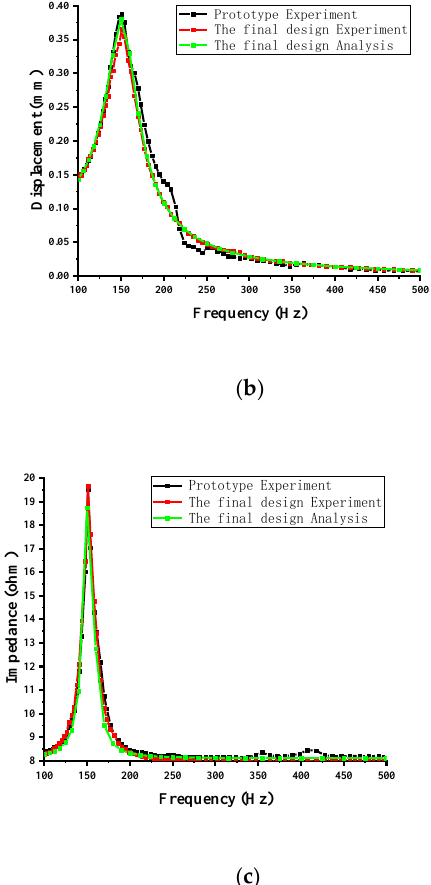
Figure 15. Results of the final design: ( a ) magnetic flux leakage, ( b ) displacement; ( c ) impedance.